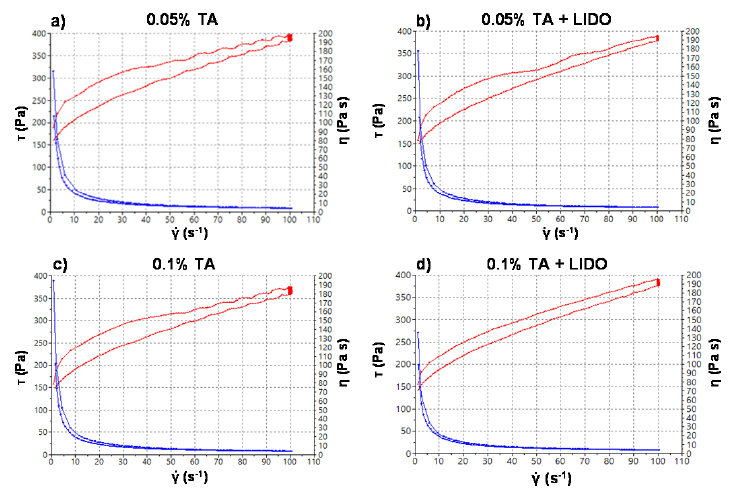
Figure 3. Viscosity curve (blue line) and flow curve (red line) of the 4 formulations under study. ( a ) 0.05% TA; ( b ) 0.05% TA + LIDO; ( c ) 0.1% TA; ( d ) 0.1% TA + LIDO, at 25 ± 0.1 °C.